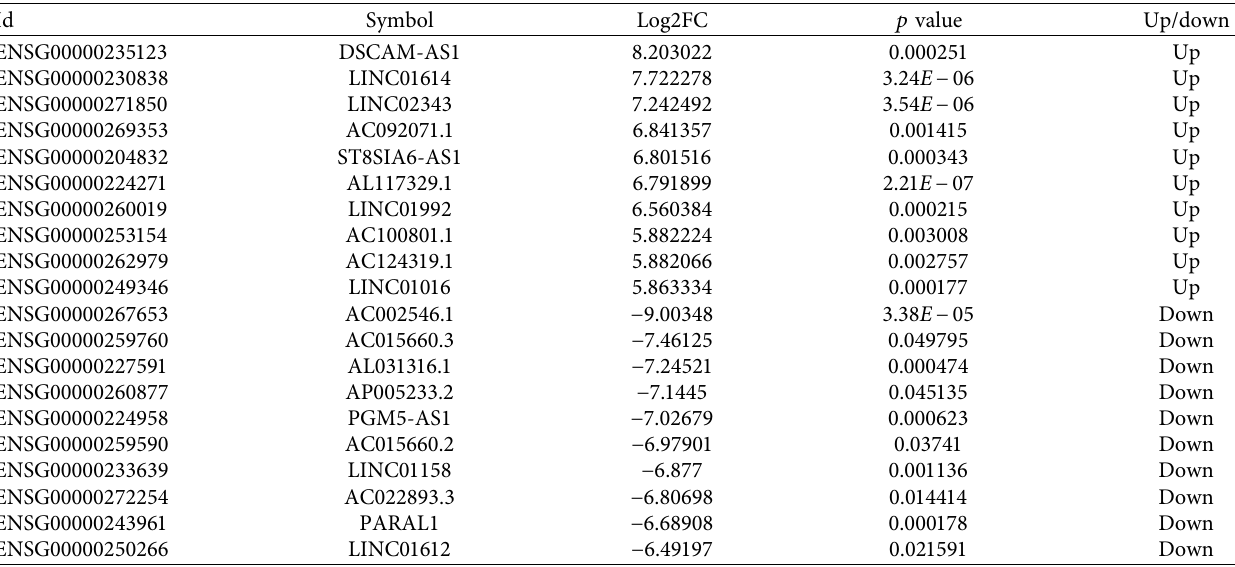
Table 3: Top 20 DElncRNAs in luminal A breast